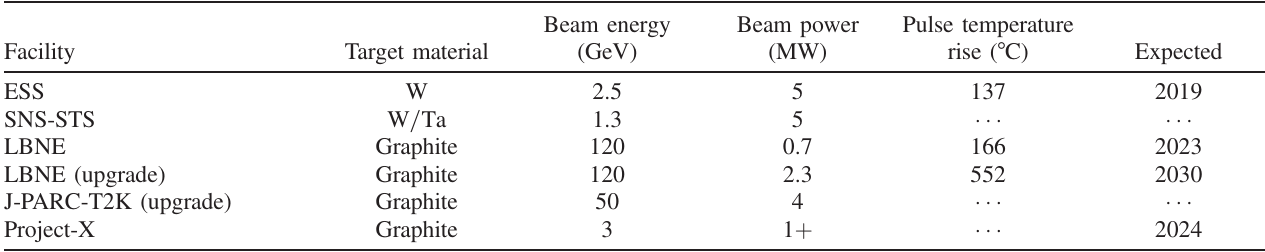
TABLE I. Future high power targets [4].